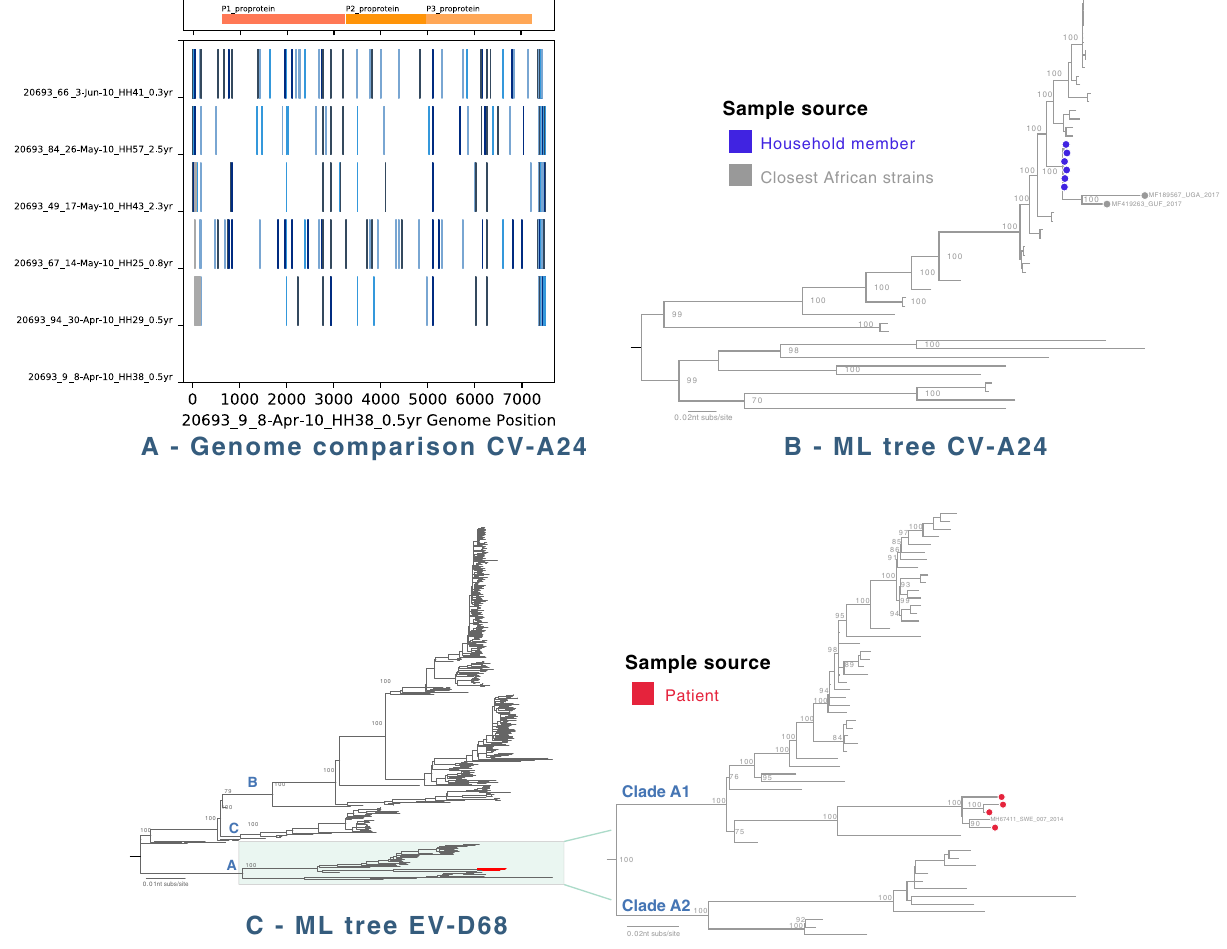
Figure 3. ( A ) Genome comparison of identified human coxsackievirus A24 (CV-A24) from the study. Kilifi CV-A24 genomes were examined and compared against the earliest Kilifi CV-A24 genome identified (20693_9, sample collected on 8 April 2010). For each genome, nucleotide changes from the first CV-A24 genome (20693_3) were indicated by vertical blue lines, gaps in the sequence were indicated by grey bars. ( B ) Maximum- likelihood phylogenetic tree of CV-A24 genomes. The ML tree compared 6 Kilifi CV-A24 genomes (all from household cohort, indicated as blue circles) to global genomes. The tree was mid-point rooted for clarity and horizontal branch lengths were drawn to the scale of nucleotide substitutions per site, and significant bootstrap values were shown for major nodes. ( C ) Human enterovirus D68 (EV-D68) maximum-likelihood phylogenetic tree. Maximum-likelihood phylogenetic tree were inferred comparing 4 Kilifi EV-D68 genomes (all from KCH pneumonia patients cohort, highlighted in red) to global genomes. The tree was mid-point rooted for clarity and horizontal branch lengths were drawn to the scale of nucleotide substitutions per site, and significant bootstrap values were shown for major nodes. These four local EV-D68 viruses belonged to clade A1, as shown in the zoomed out